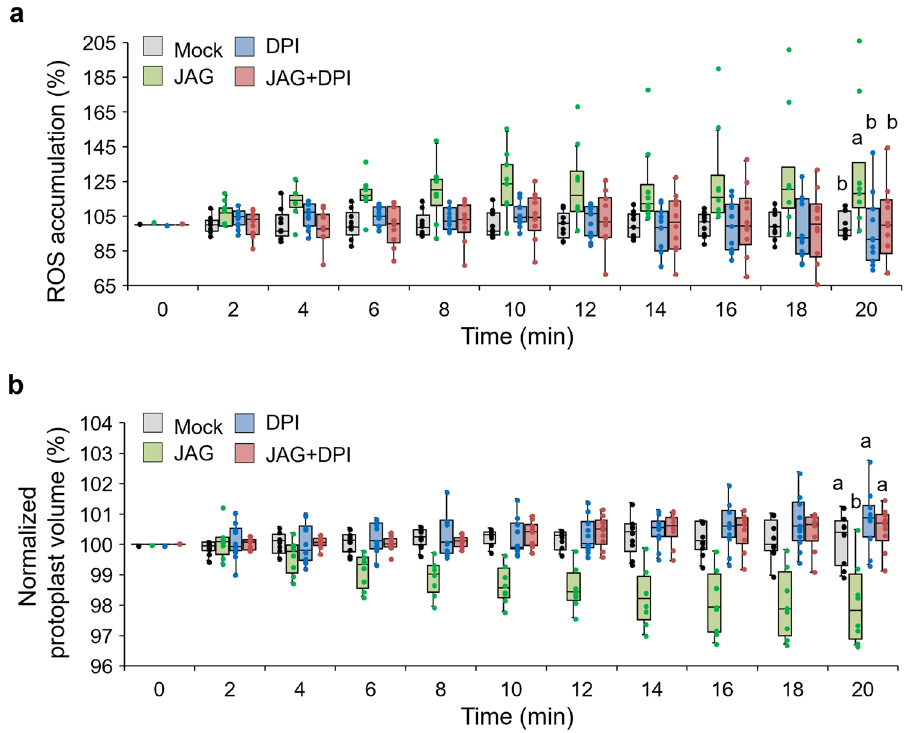
Figure 4. Effect of DPI on JAG-induced ROS accumulation in tertiary extensor of Samanea saman . ( a , b ) Effects of diphenyleneiodonium chloride (DPI) on 12-hydroxyjasmonic acid glucoside (JAG)-induced ( a ) cytosolic reactive oxygen species (ROS) accumulation and ( b ) cell shrinkage in tertiary extensor protoplasts of S. saman . Protoplasts were preincubated for 30 min with 12.5 µM DPI before adding 100 µM JAG. All data points are shown as dot plots (n = 8–11). Different letters indicate significant differences (SNK post-hoc test, P < 0.05). All experiments were conducted during ZT 6–11. Four independent experiments were